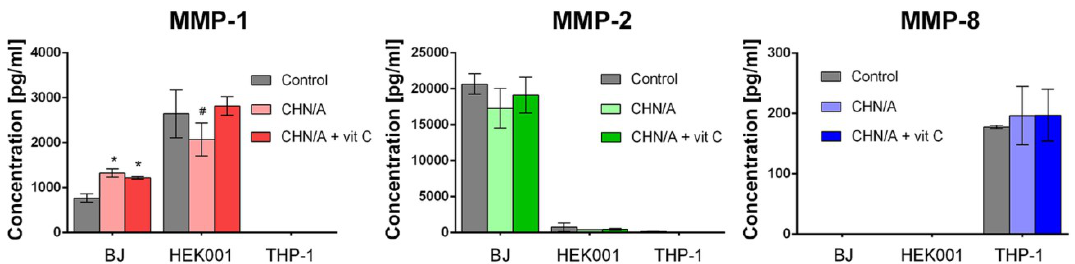
Figure 5. The level of metalloproteinases (MMPs) produced by human fibroblasts, keratinocytes, and macrophages cultured for 4 days on the surface of the films assessed by ELISAs (control—cells cultured on theglasscoverslip, BJ—humanskinfibroblasts,HEK001—humanepidermalkeratinocytes,THP-1—human macrophages differentiated from THP-1 cell line, * statistically significant results compared to the control cells; # statistically significant results compared to the CHN / A + vit C sample; n = 3 (three independent samples were tested), p value < 0.05, one-way ANOVA followed by Tukey’s